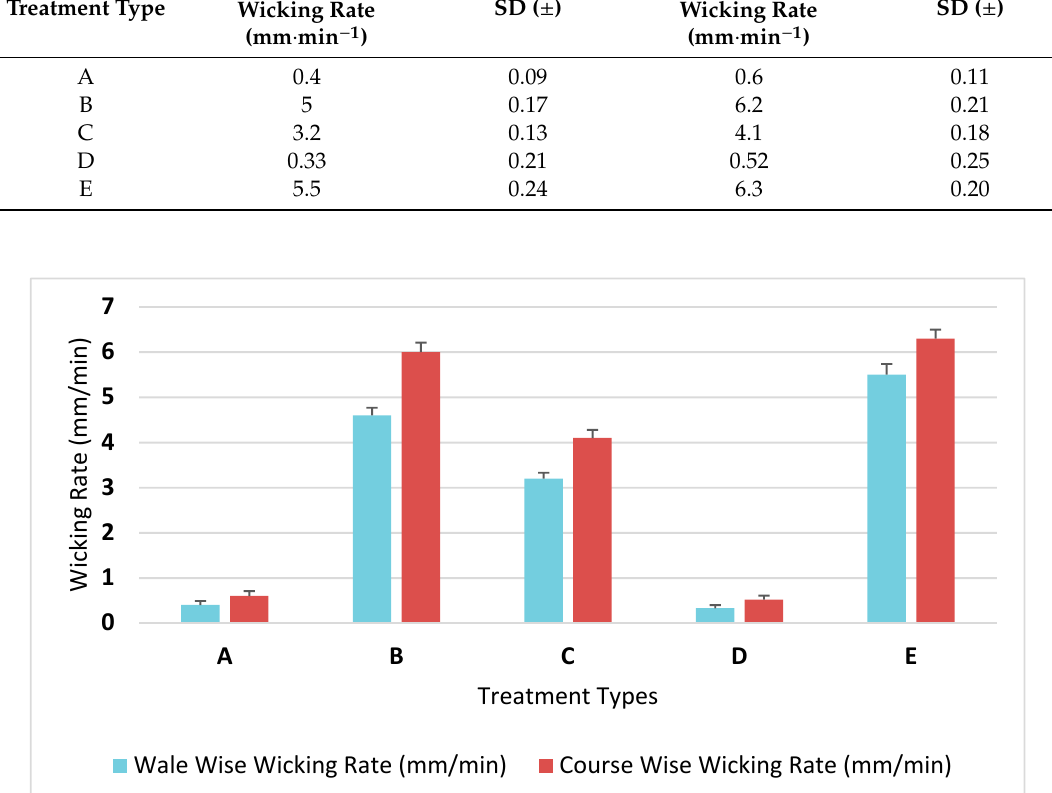
Table 6. E ff ect of finishes treatments on wale-wise and course-wise vertical wicking rate (mm · min − 1 ). Treatment Type Treatment